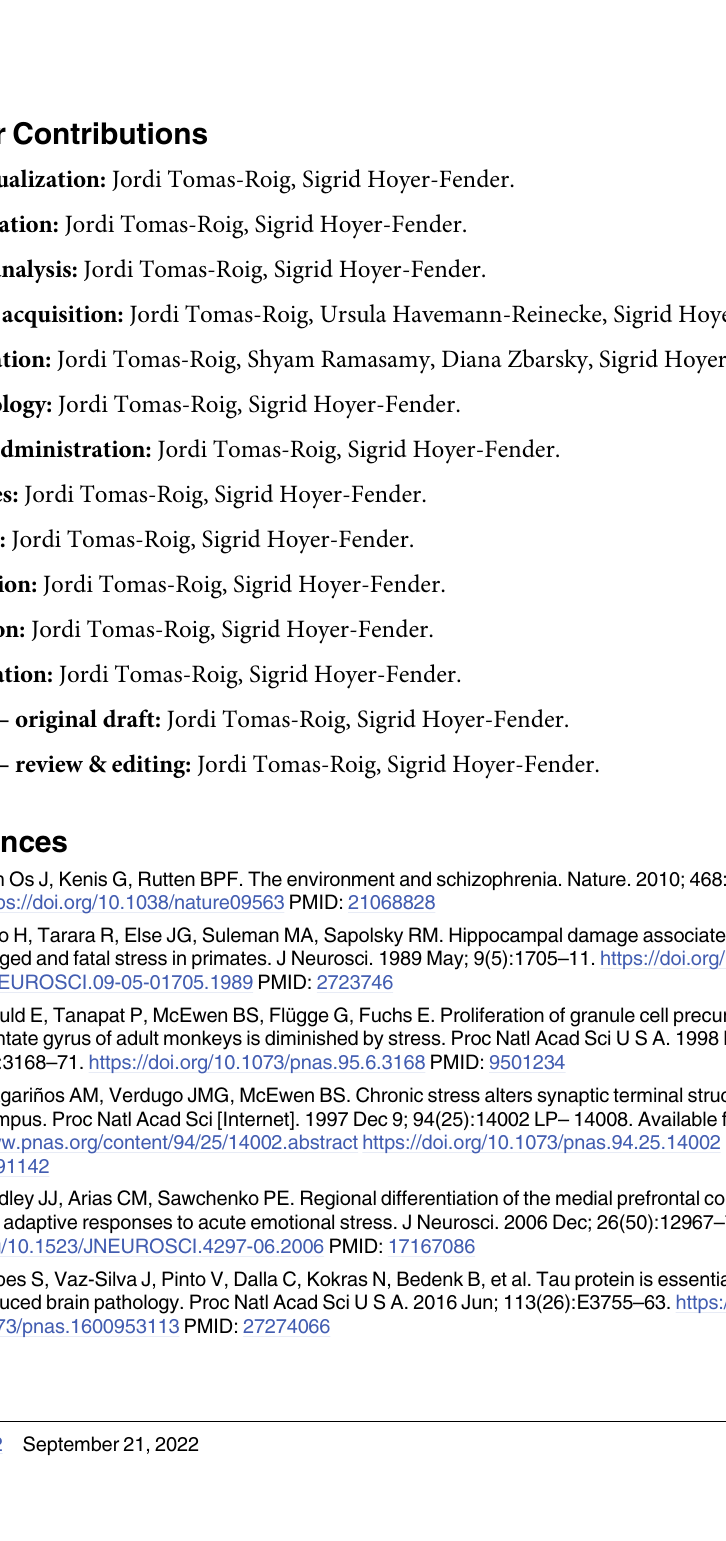
S1 Table. Analyses of relative α -tubulin acetylation in the prefrontal cortex (PFC), the hip- pocampus (HIPP), the dorsal striatum (DS), and the cerebellum (CRB) in control (CTR) and stressed (STS) mice. Treatment with either vehicle ( V+V), rimonabant